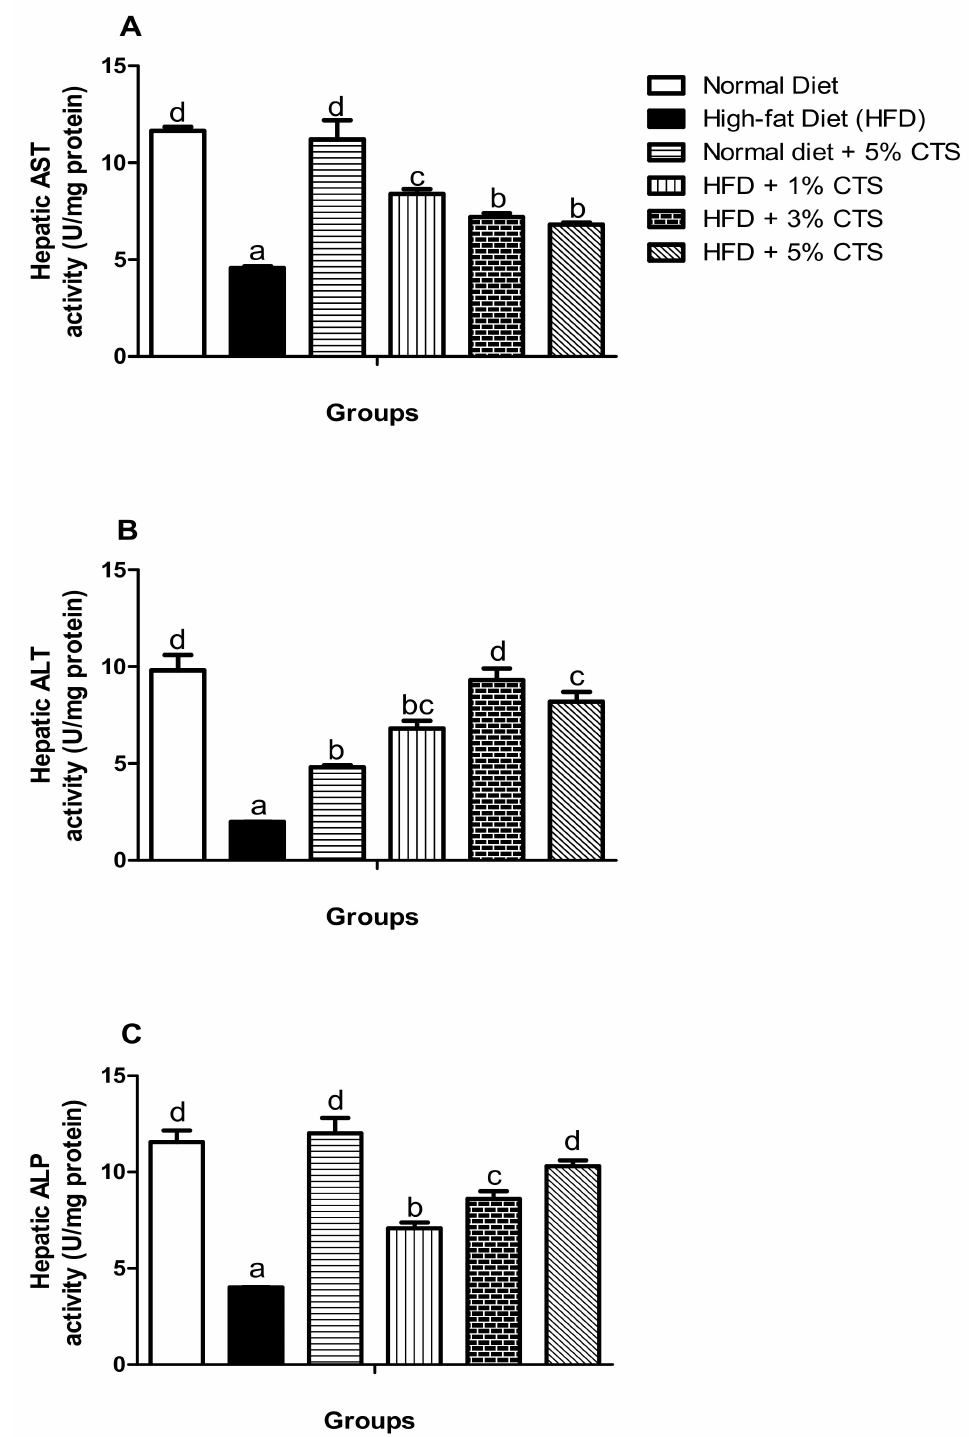
Figure 2. Effects of chitosan supplementation on hepatic biomarkers of High-fat diet (HFD)-fed rats. Values are expressed as mean ± SEM ( n = 5). Bars with distinct letters are statistically ( p < 0.05) different. a–Hepatic AST activity; b–Hepatic ALT activity; c–Hepatic ALP. AST–Aspartate amino- transferase; ALT–Alanine aminotransferase; ALP–alkaline phosphatase;